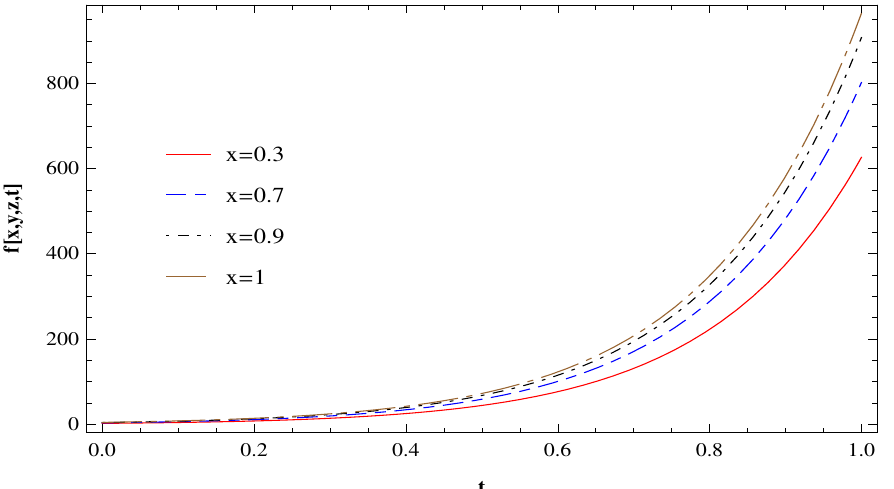
Figure 12. The FRDTM solutions f ( x , y , z , t ) for different values of x ; β = 1; t ∈ [ 0,1 ] , z = 0.5, and y =